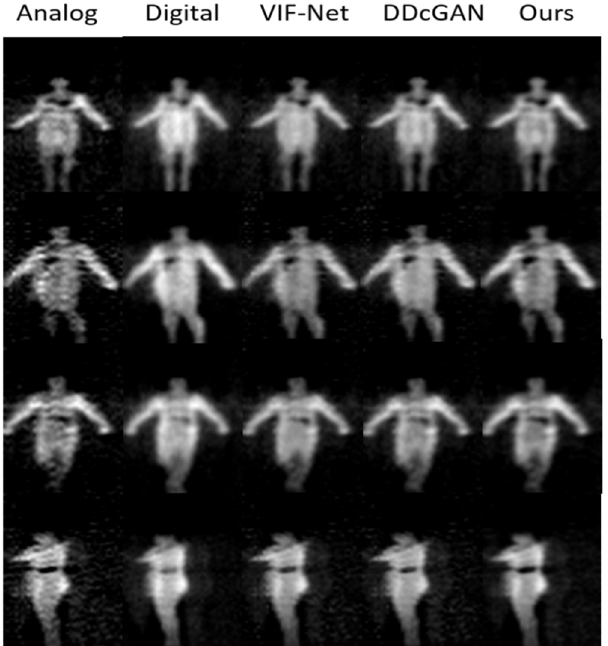
Figure 12. Example of anomaly detection dataset. The area contained in the bounding box is the abnormal area caused by the threats.